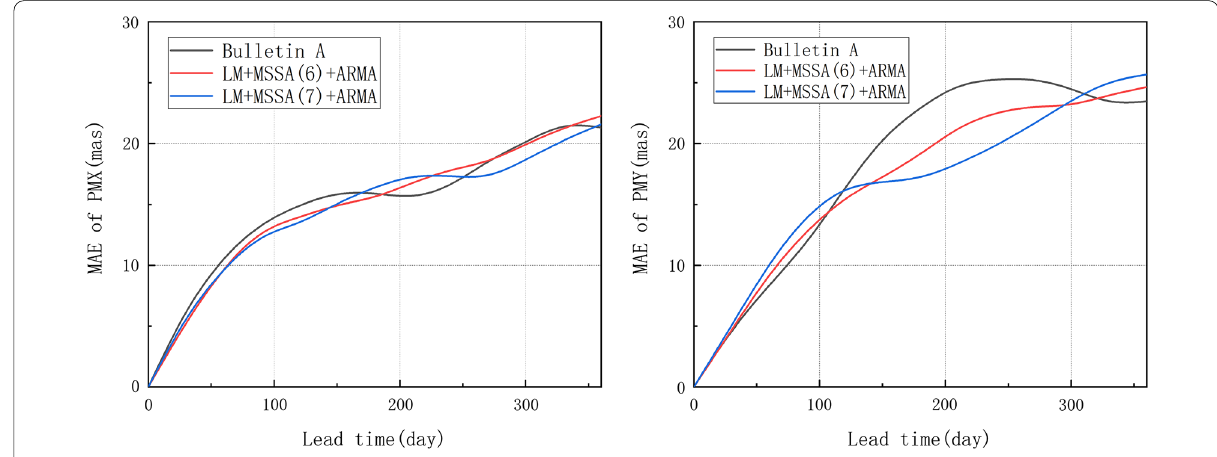
Fig. 8 MAE of IRES Bulletin A and LM